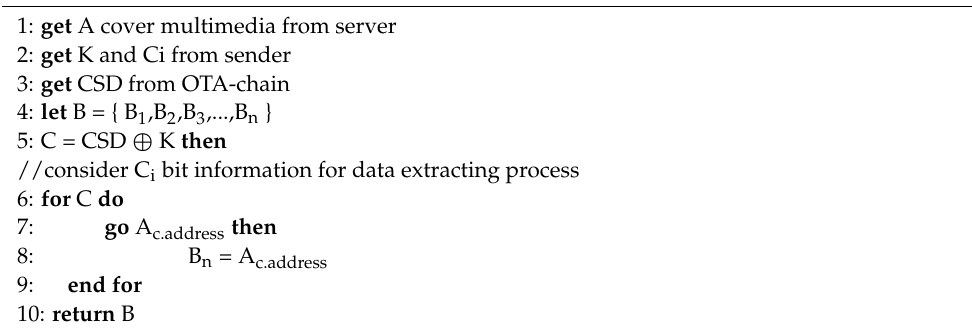
Algorithm 2. Inverse OTA-Steganography